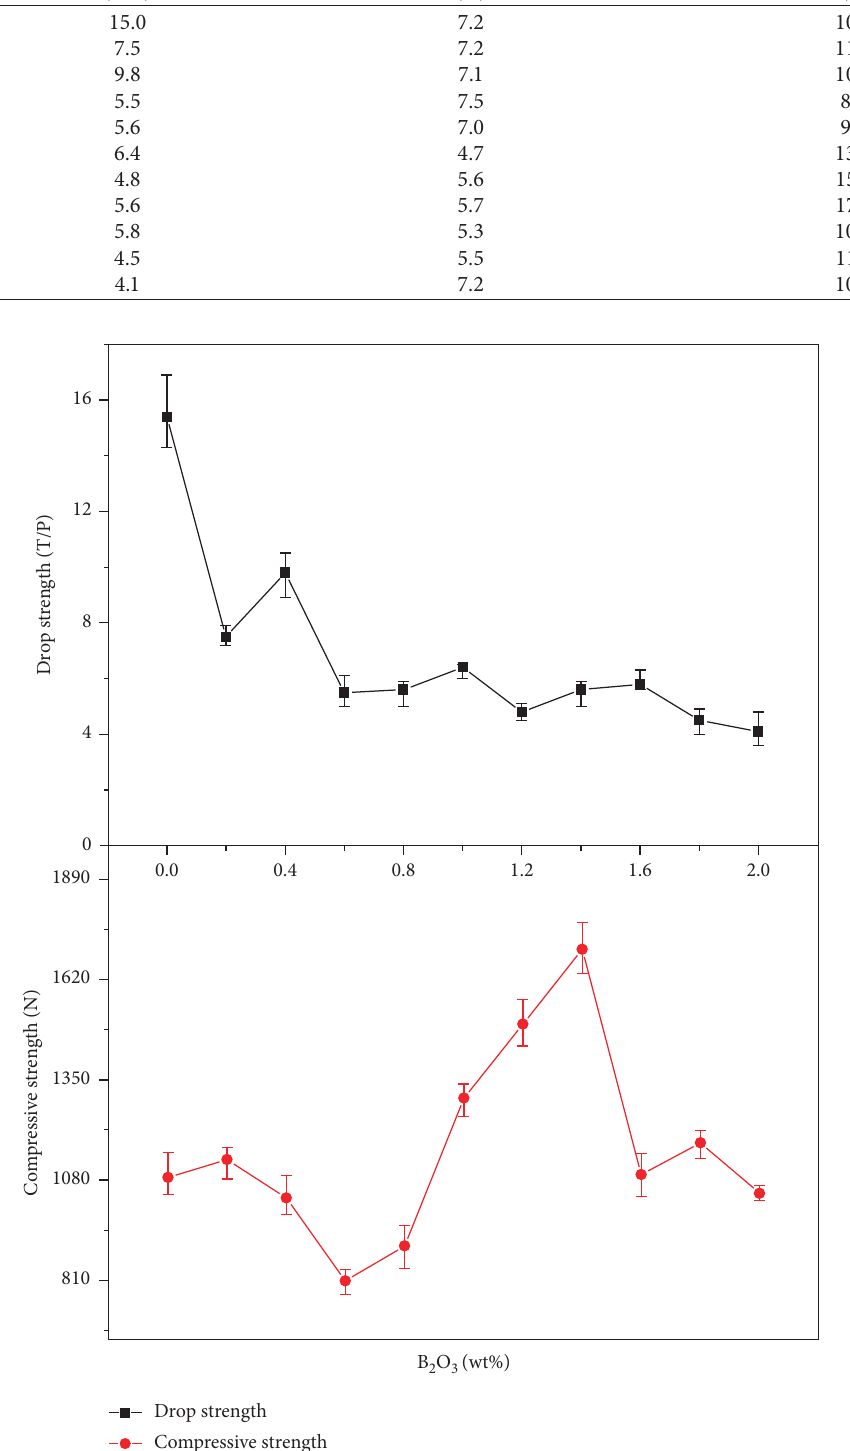
Figure 4: Drop strength and compressive strength of vanadium-titanium pellets with B